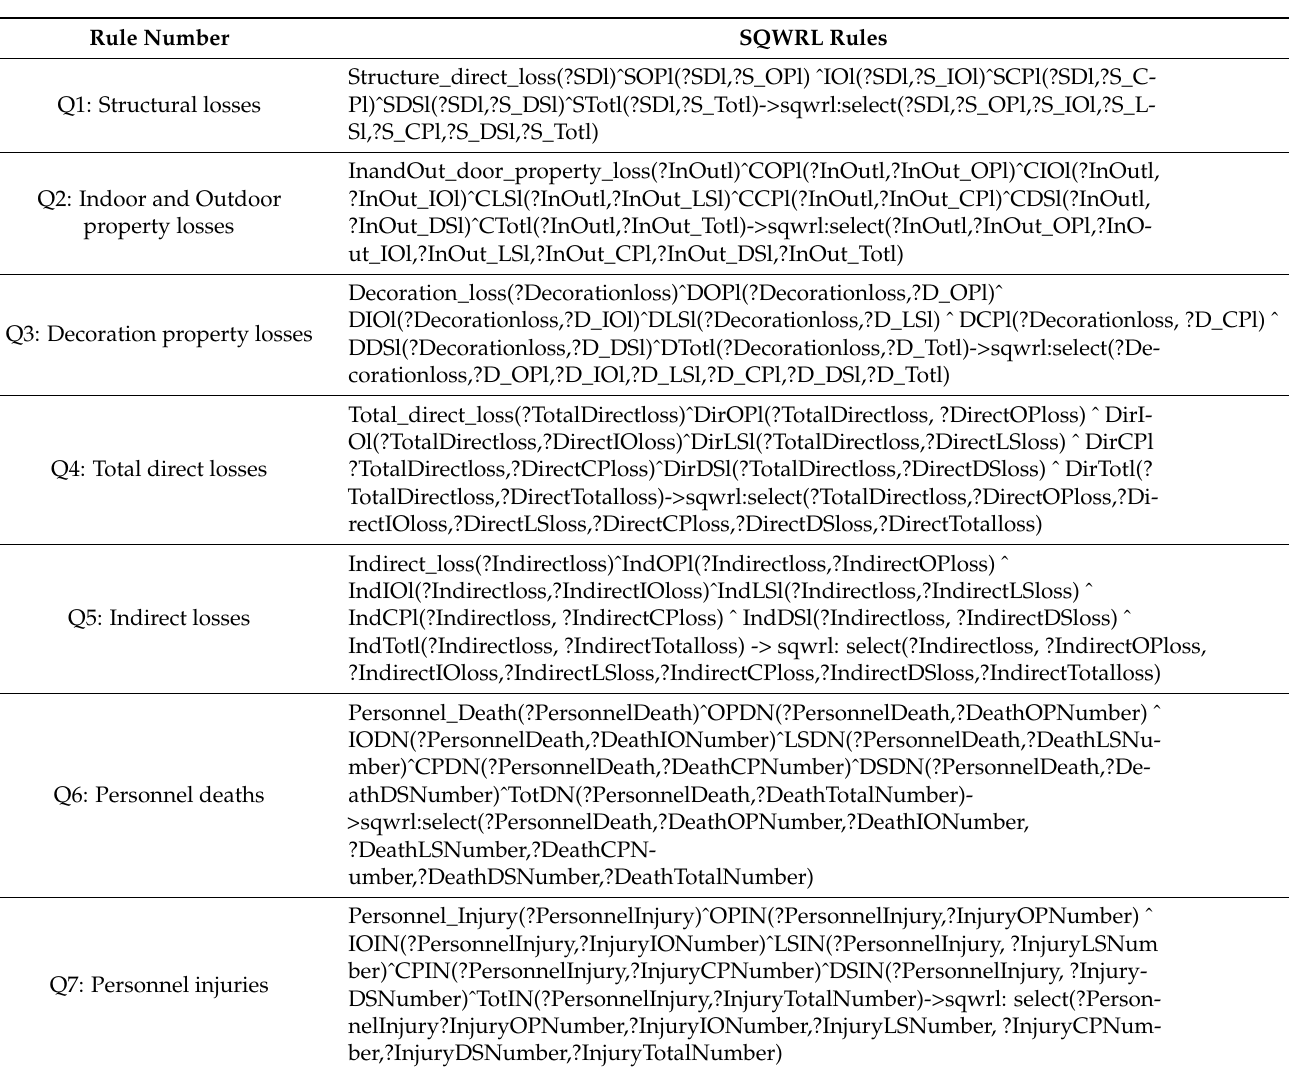
Table 12. SQWRL rules.